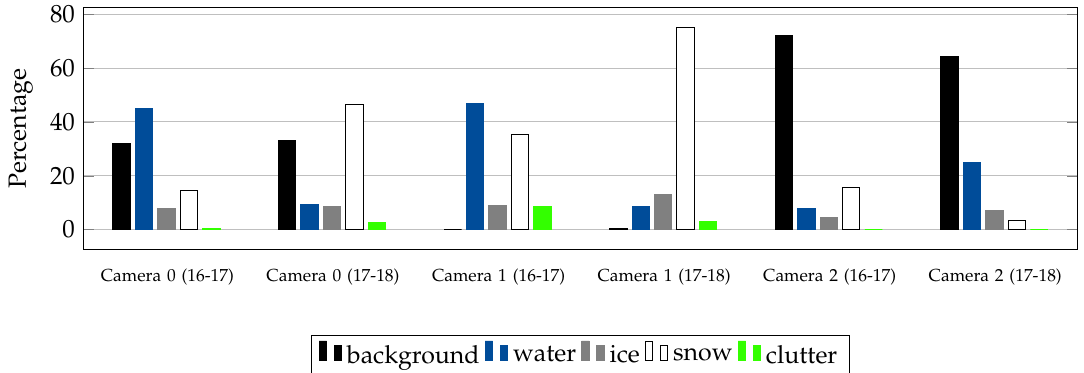
Figure 7. Bar graphs displaying class imbalance (including the class background ) in our dataset. Ice and clutter are the under-represented classes.